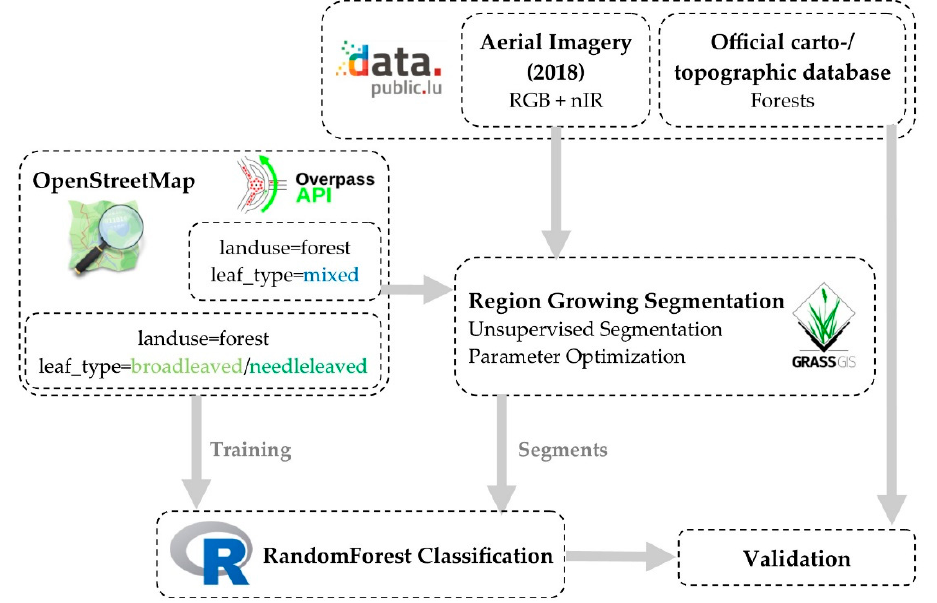
Figure 2. Schematic of the processing workflow.